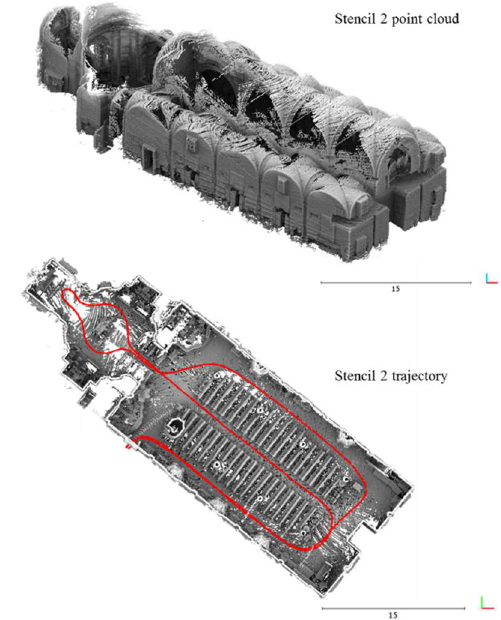
Figure 8. KAARTA Stencil 2 dataset obtained following the second path: the 3D point cloud (top of the image) and the estimated trajectory (lower part of the